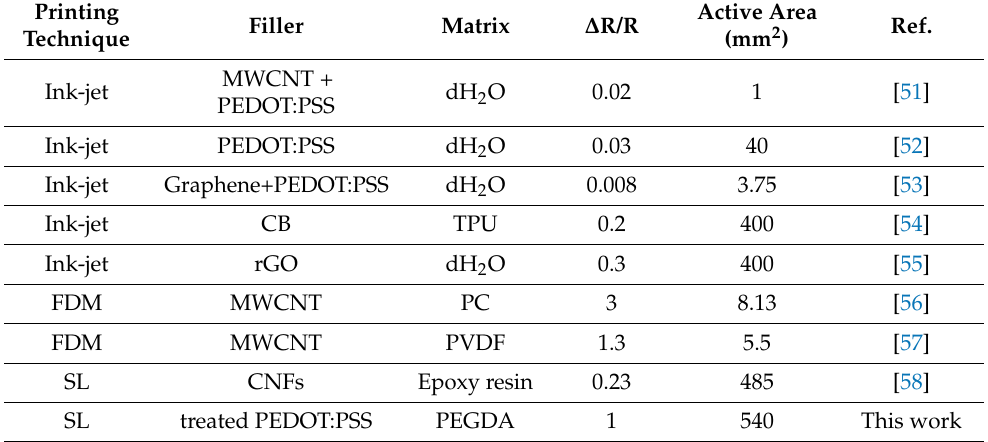
Table 1. State-of-the-art of 3D-printed cumulative adsorption materials for acetone and